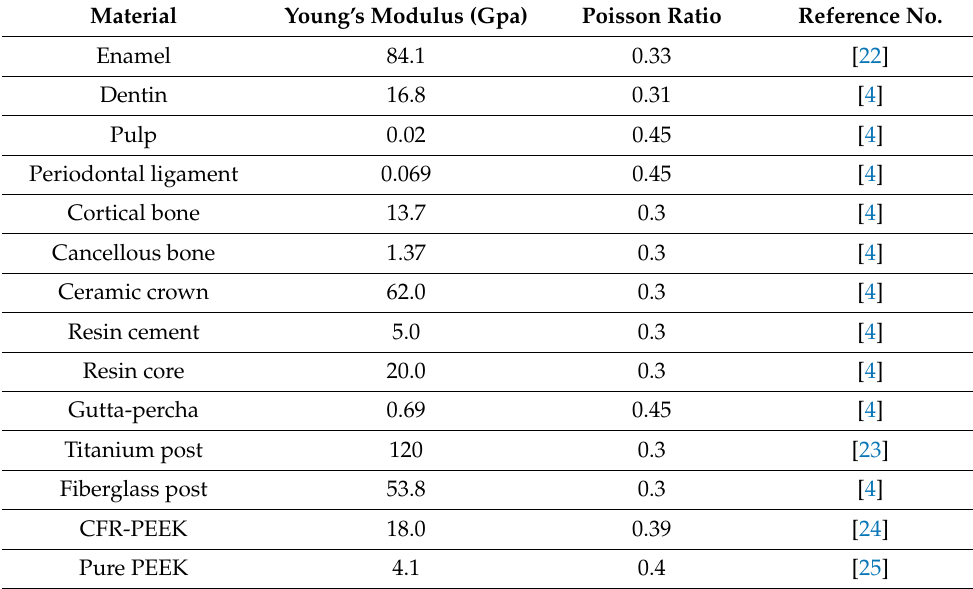
Table 1. Mechanical properties of each material.